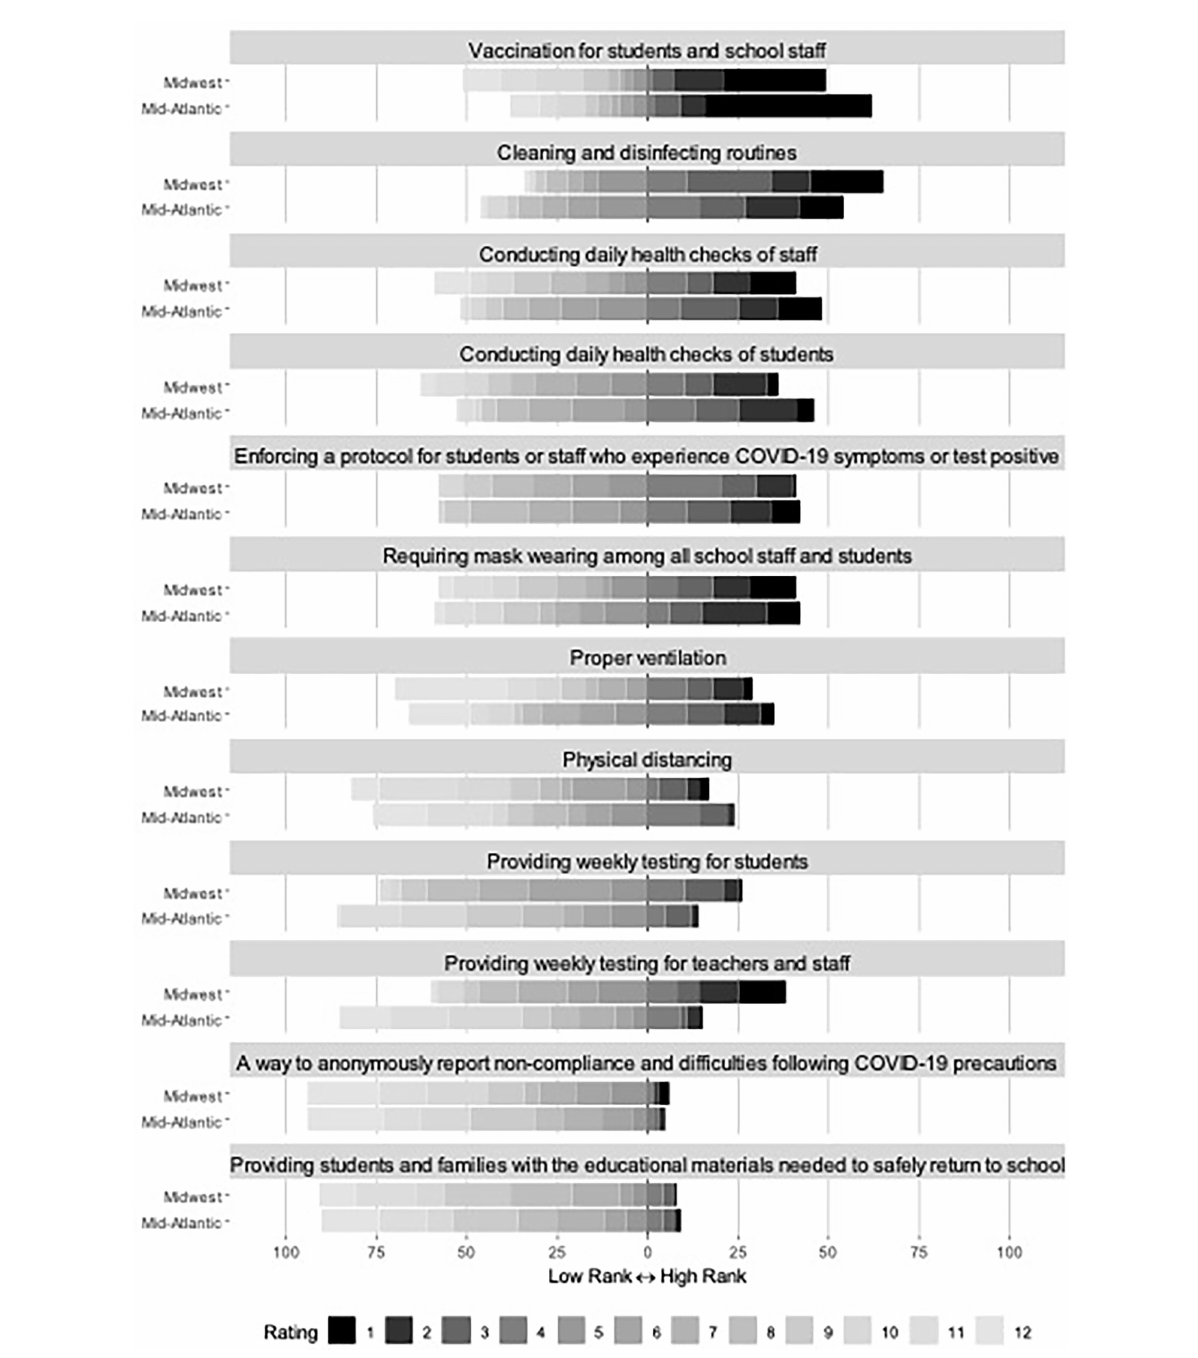
FIGURE 2 Educators’ perceived helpfulness of COVID-19 mitigation strategies in the school setting. Items were ranked in order of what educators found to be most helpful